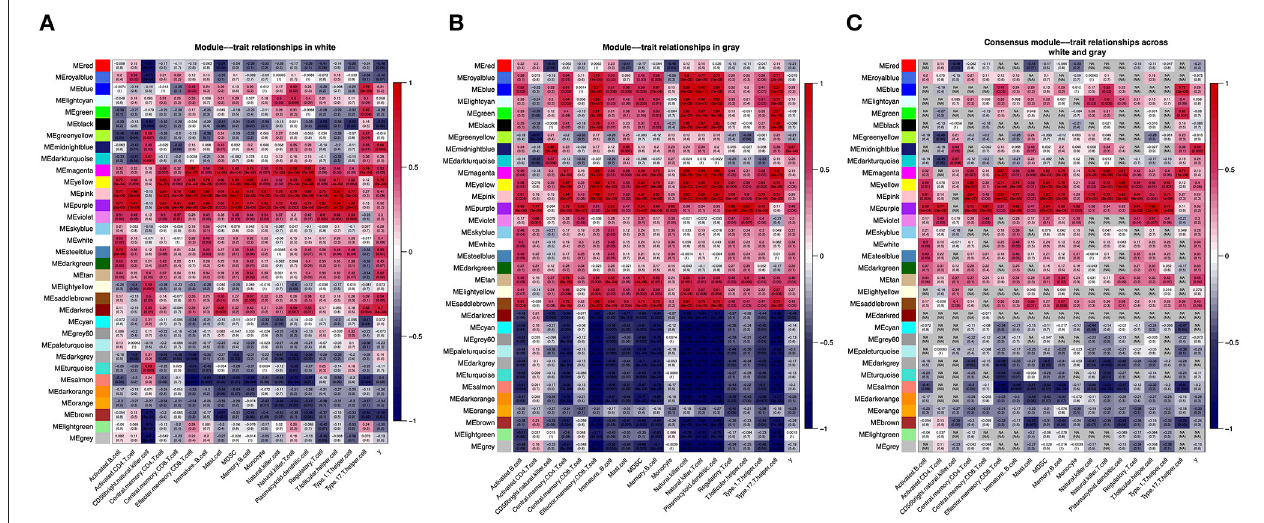
FIGURE 3 | WM–GM consensus module construction. (A) Pearson correlation coefficients between the ssGSEA scores and module eigengenes (MEs) in WM dataset; numbers in brackets indicate the corresponding p- values. (B) Pearson correlation coefficients between the ssGSEA scores and module eigengenes in GM dataset; numbers in brackets indicate the corresponding p- values. (C) Pearson correlation coefficients between the ssGSEA scores and consensus module eigengenes; numbers in brackets indicate the corresponding p-